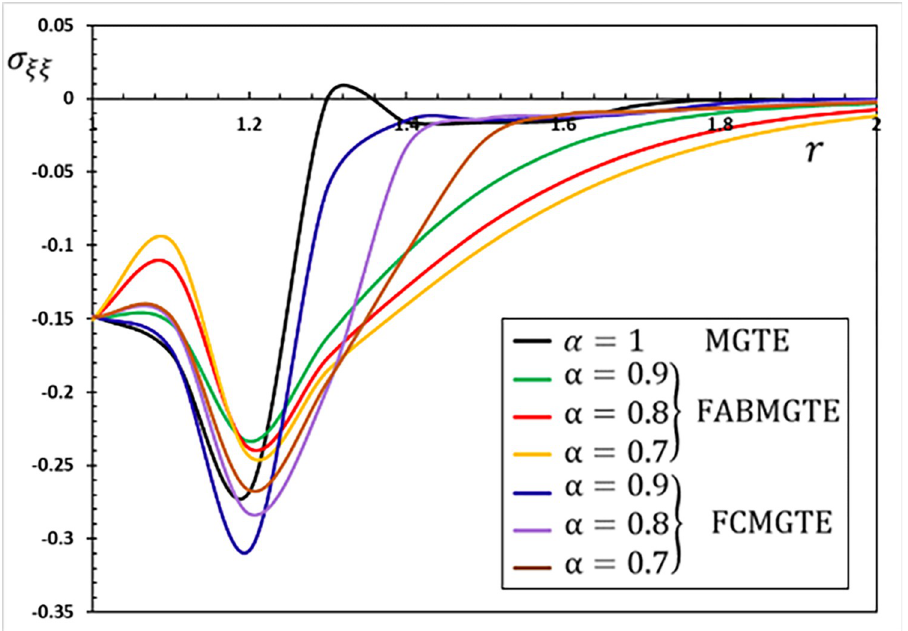
Fig 12. The hoop stress variation σ ξξ for different fractional operator